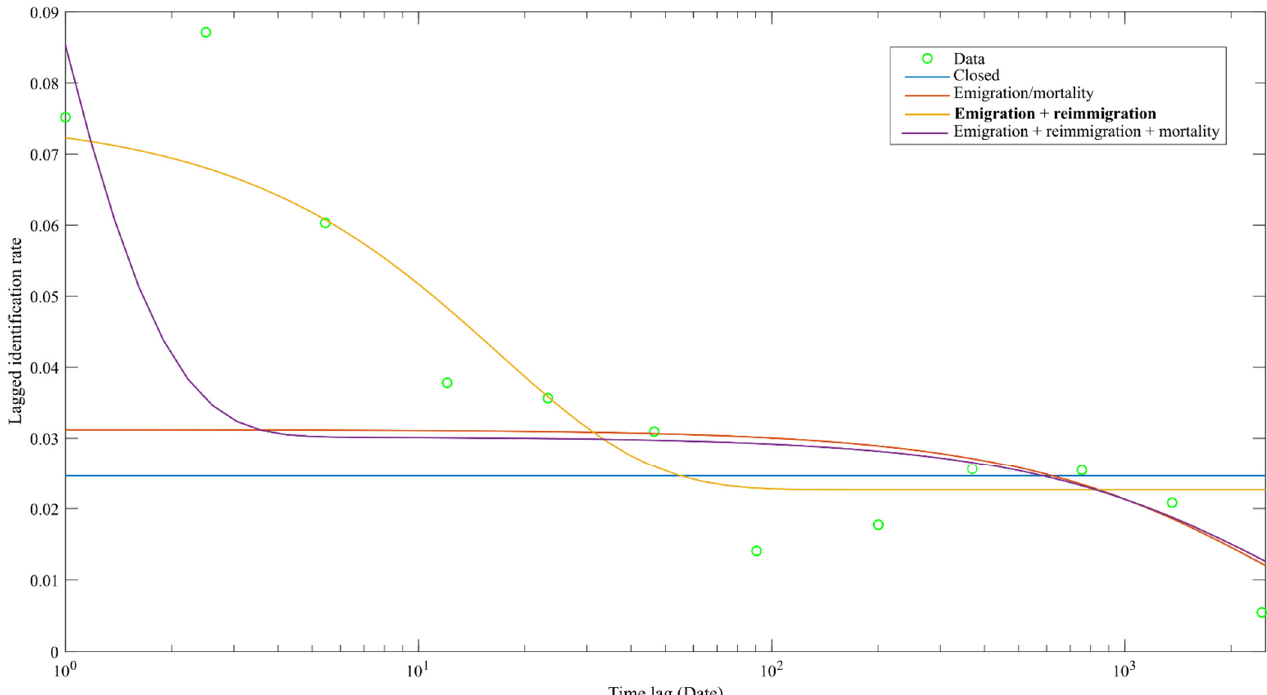
Figure 5. Lagged identification rate (LIR) of bottlenose dolphins sighted at least three times in the Gulf of Taranto. Data are represented by green circles, models tested are represented by different colored curves according to the legend. In bold the best model selected by QAIC. Table 3. Models fitted to LIR data from the Gulf of Taranto. The model that best fit the data according to QAIC is shown in bold. Δ QAIC indicates how well the data support the less favored model (Burham and Anderson 2002).